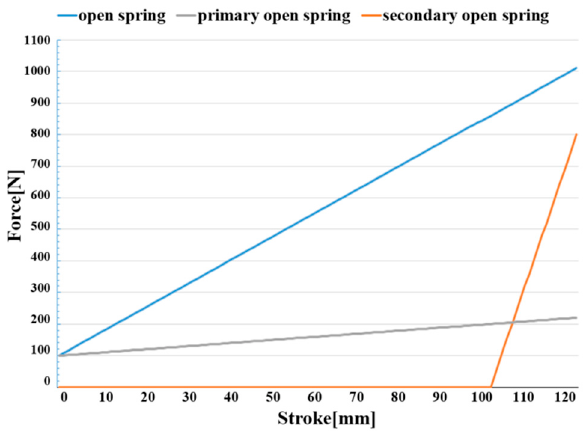
Figure 14. Open spring force comparison of two types of spring.